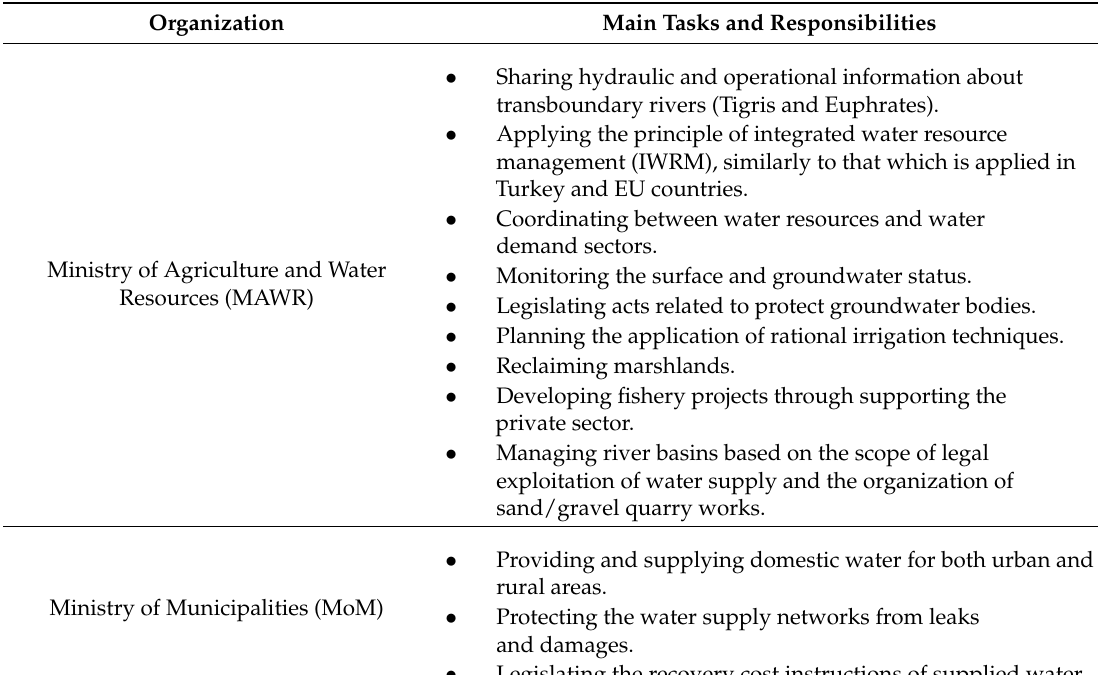
Table 1. Responsibilities of Iraqi water